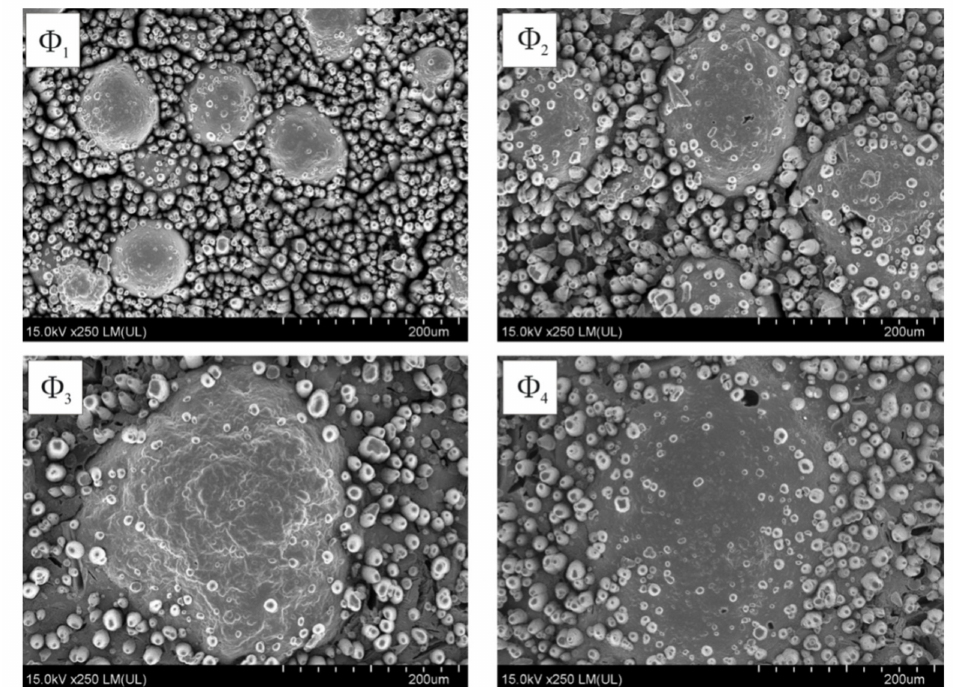
Figure 10. SEM images of laser irradiated (N = 500; E th = 100 mJ/cm 2 ) and electroless metallized coatings containing glass microspheres Φ 1 , Φ 2 , Φ 3 or Φ 4